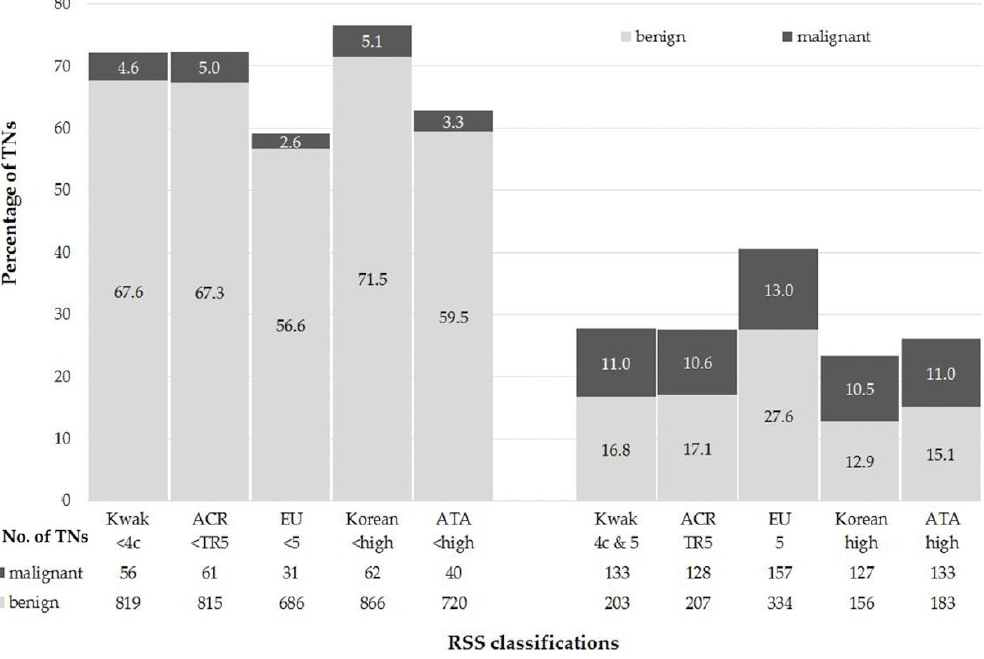
Figure 2. Performance of the risk stratification systems (RSSs). Abbreviations: TNs—Thyroid Nodules; ACR—American College of Radiology; EU—European Union; ATA—American Thyroid Association; RSS—Risk Stratification System.